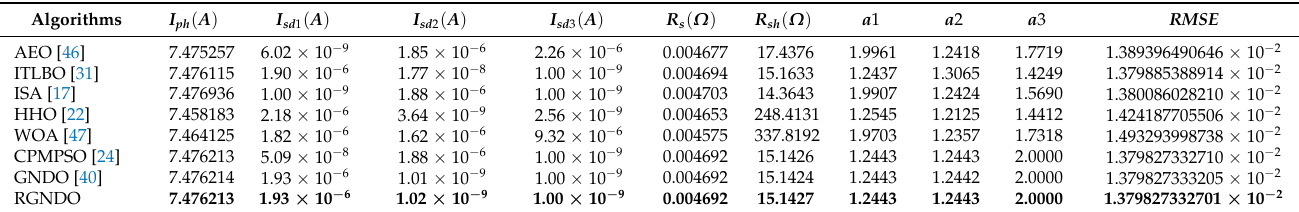
Table 11. Comparison of the best RMSE and its extracted parameter per cell on STP6-120/36.